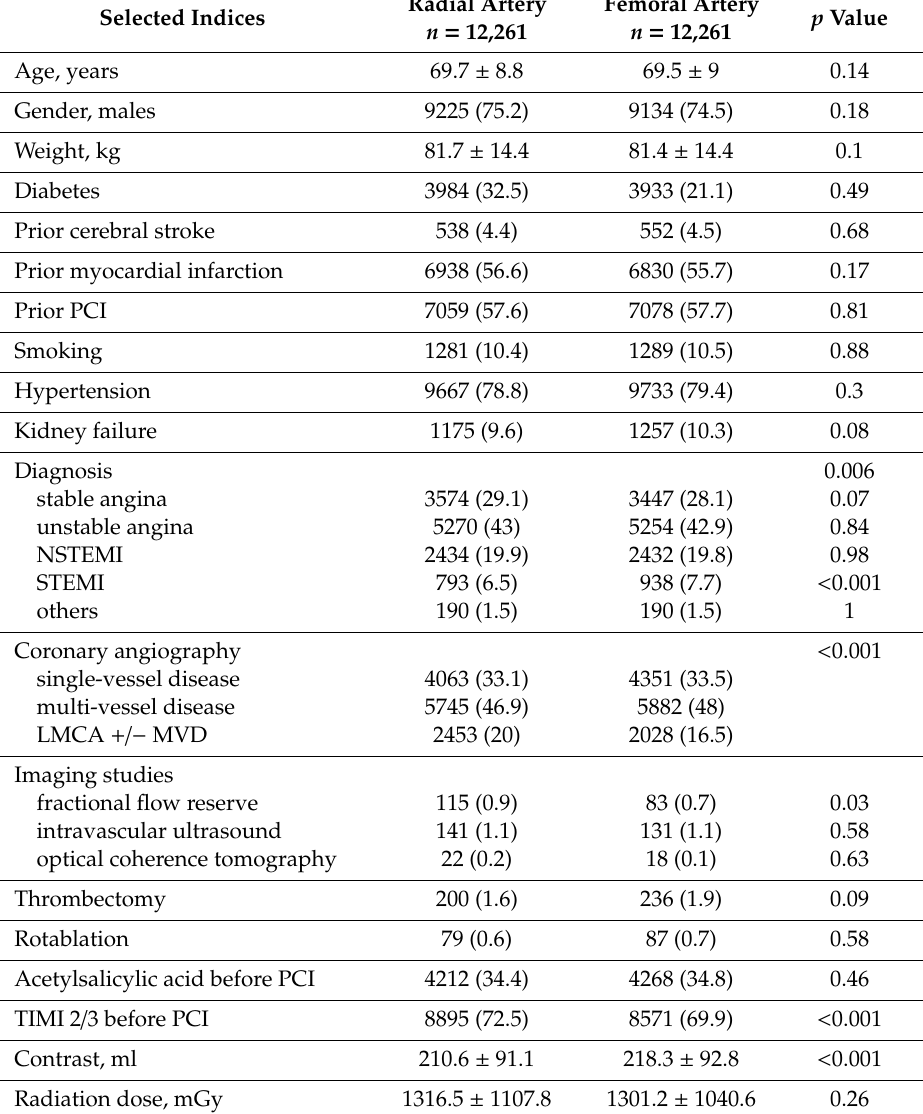
Table 2. General patient characteristics according to radial and femoral access in the overall group of patients following propensity score